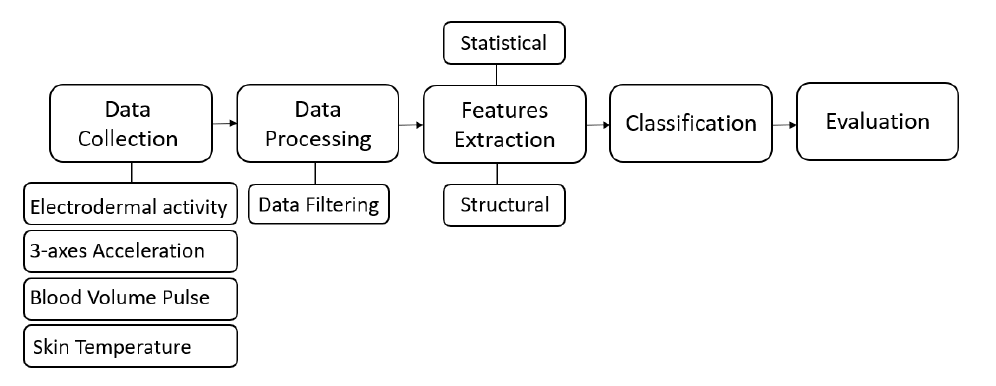
Figure 1. The framework of this